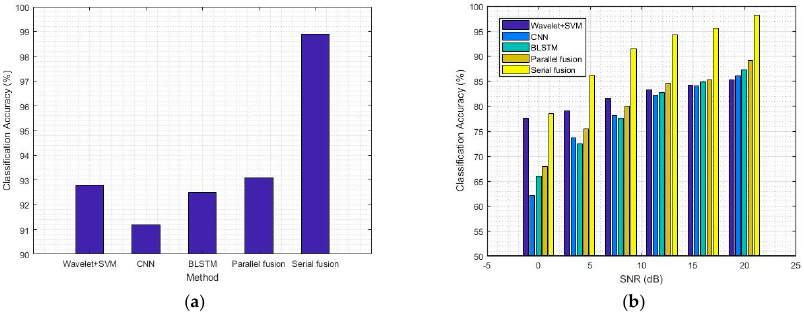
Figure 6. Comparison of classification accuracy between the deep learning models and the traditional method. ( a ) Classification accuracy of different methods without noise; ( b ) Classification accuracy of different methods with SNR from 0 dB to 20 dB.